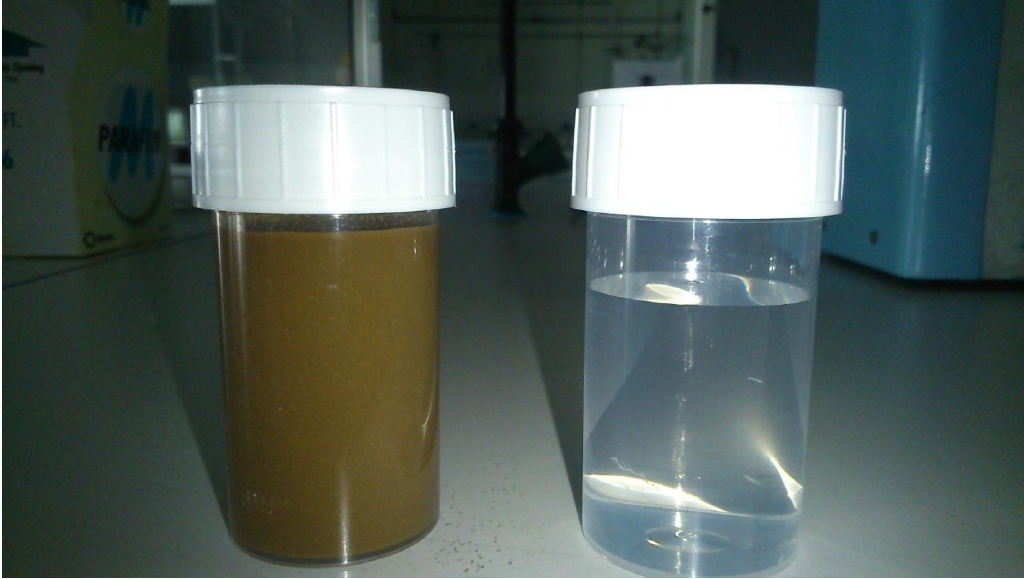
Figure 8. Aspect of OMWW (left) and recovered-condensed water from raw OMWW (right).